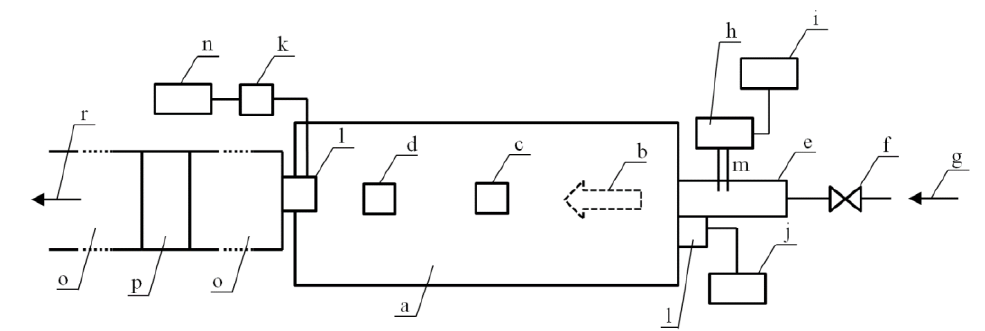
Figure 1. Diagram of the test stand designed for research on the impact of dust concentration on the propagation of ultrasonic waves; a — measuring tunnel, b — direction of airflow, c — anemometer, d — dust meter, e — blow-out nozzle, f — valve, g — compressed air supply, h — dust container with